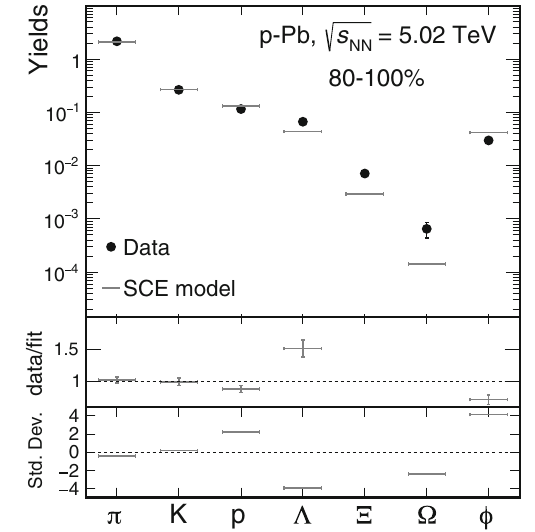
Fig. 5 Comparison of data with fits for the most peripheral collisions. The lower part of the figure shows the standard deviation. The standard deviation for the (cid:6) is 5.5. While the ratios data/fit for the (cid:6) and (cid:8) are 2.45 and 4.6 respectively